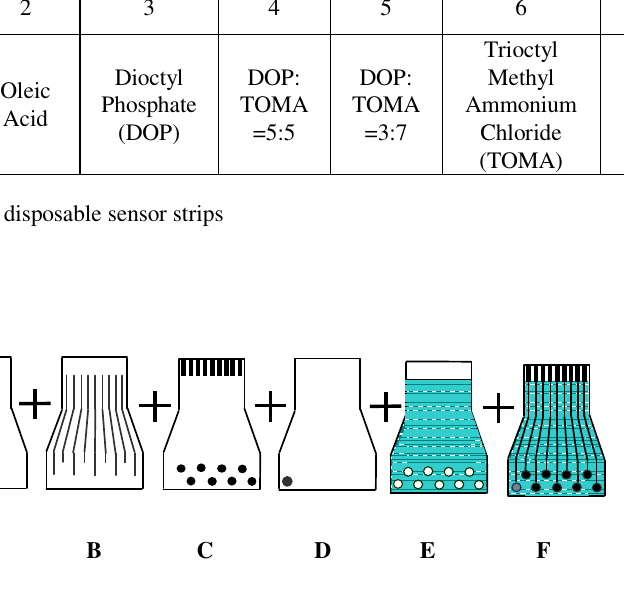
Fig.1 . Scheme of a screen-printed strip